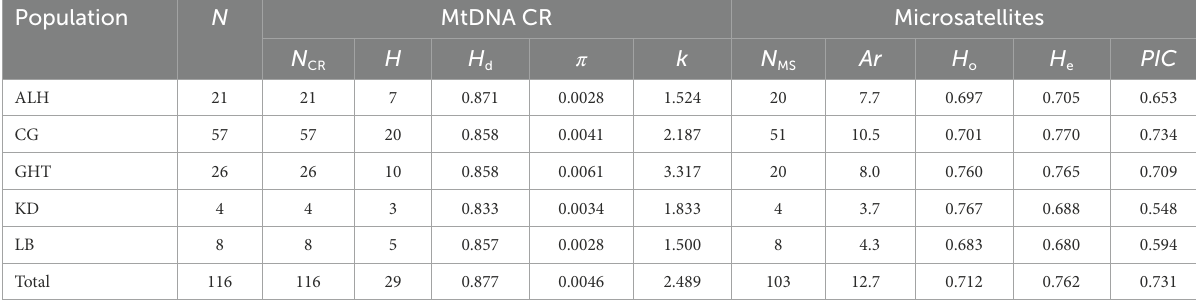
TABLE 1 Genetic diversity of Jankowski’s Bunting based on mitochondrial control region and 15 microsatellite loci. Population N MtDNA CR